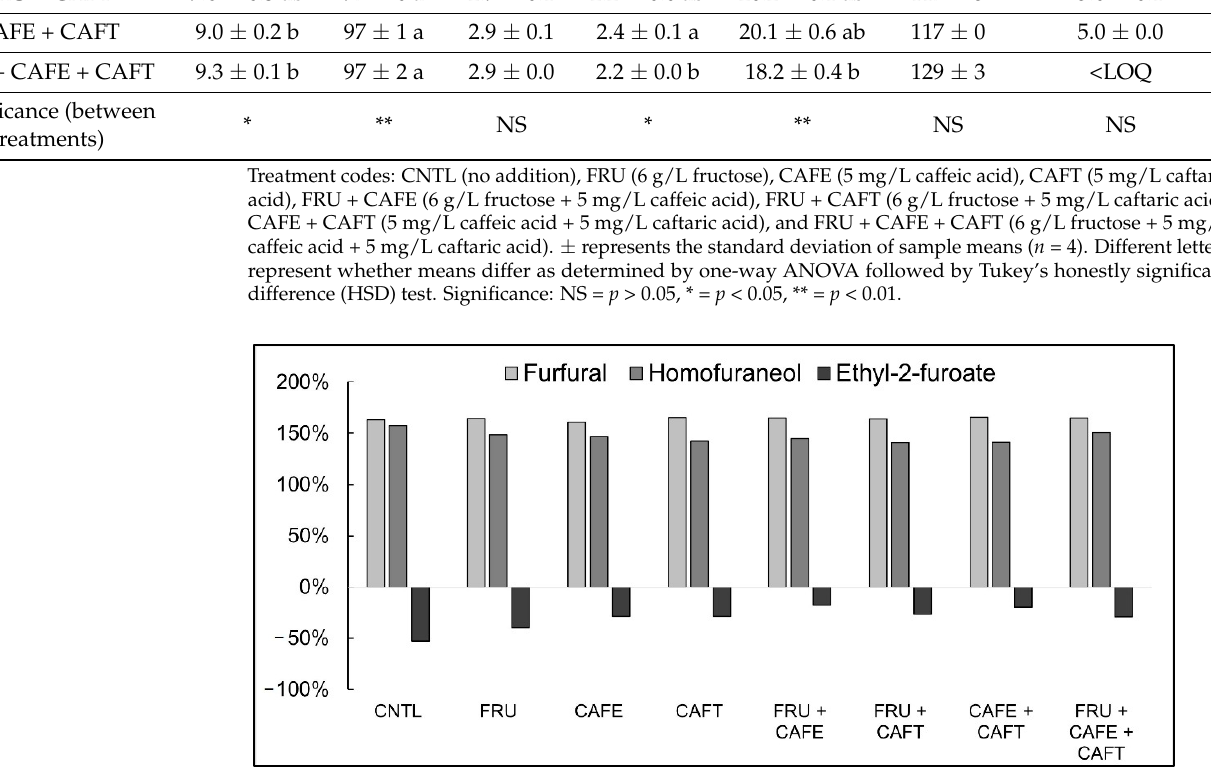
Figure 2. Percent difference between furan-derived compound concentrations stored at 30 °C and 15 °C for 90-days. Percent difference was calculated as follows: |A − B|/[(A + B)/2] × 100%, where A is the compound concentration determined for the 30 °C sample, and B is the concentration determined for the 15 °C sample. +X% is interpreted as a greater concentration determined at 30 °C compared to 15 °C, while − X% is interpreted as a lower concentration. Treatment codes: CNTL (no addition), FRU (6 g/L fructose), CAFE (5 mg/L caffeic acid), CAFT (5 mg/L caftaric acid), FRU + CAFE (6 g/L fructose + 5 mg/L caffeic acid), FRU + CAFT (6 g/L fructose + 5 mg/L caftaric acid), CAFE + CAFT (5 mg/L caffeic acid + 5 mg/L caftaric acid), and FRU + CAFE + CAFT (6 g/L fructose + 5 mg/L caffeic acid + 5 mg/L caftaric acid).